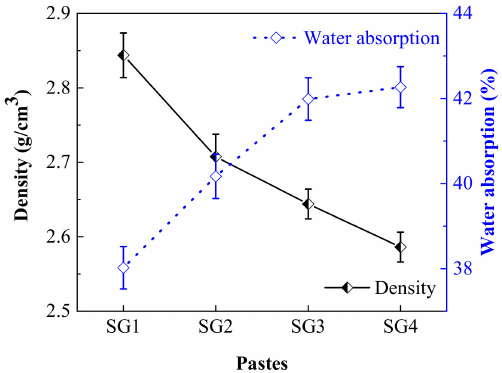
Figure 4. Density ( black ) and water absorption ( blue ) of the pastes at 28 d.